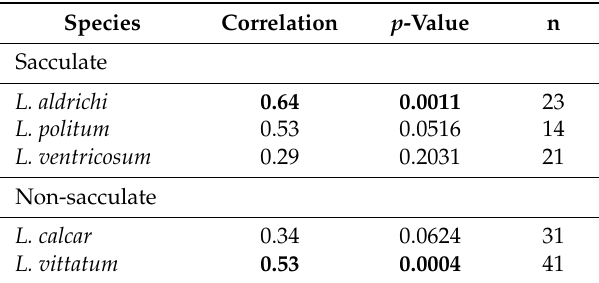
Table 1. Correlations between the principal component describing male body size and pedipalp length generated using Pearson product-moment correlations. Bolded values indicate p < 0.05, and ‘n’ indicates the number of individuals used in the analysis. Species are arranged from low antagonism at the top of the table to high antagonism at the bottom, and categorized by the possession of penile sacs (sacculate) or the absence of penile sacs (non-sacculate). Species